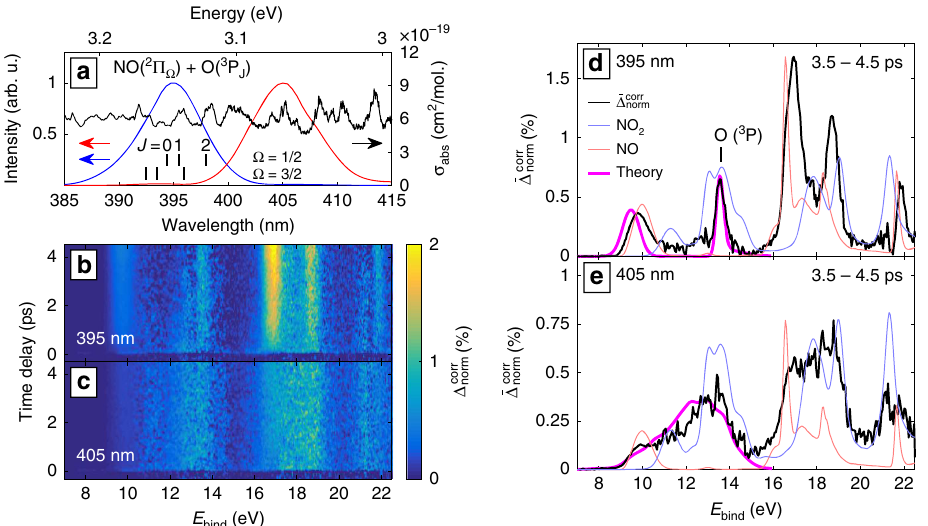
Fig. 6 Photoelectron spectra of dissociated and highly-excited, but still bound NO 2 molecules. a The wavelength-dependent absorption spectrum of NO 2 (black) 60 with the individual dissociation thresholds for vibrationally cold NO 2 62, 63 , together with two excitation spectra — one dominantly above (blue) and one dominantly below (red) the dissociation threshold. b , c Depletion compensated relative difference spectra for those two excitation spectra. The excitation fraction in both data sets ( b , c ) is about 0.9%. d , e Mean depletion -compensated relative difference for both spectra integrated over the delay range of 3.5 to 4.5 ps. In both cases the XUV-only spectra of NO 2 and NO are overlayed (see text). The NO spectra were acquired with a different magnetic-bottle spectrometer 61 . The photoelectron spectra predicted by our wave-packet calculations are shown as